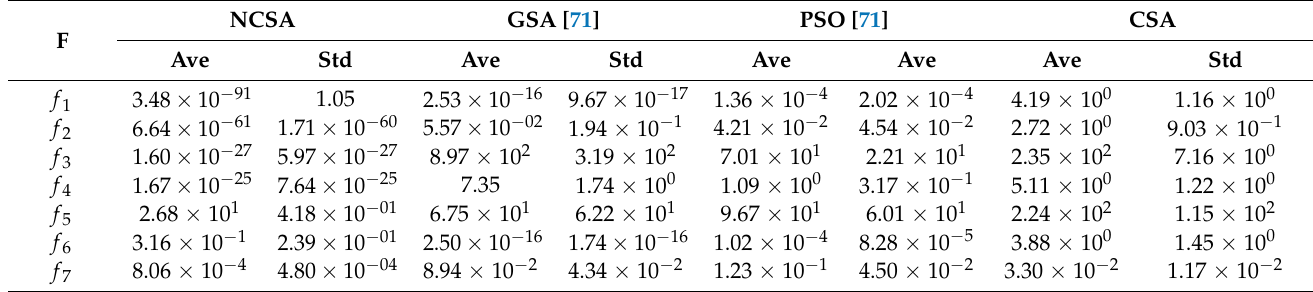
Table 1. Results for unimodal benchmark